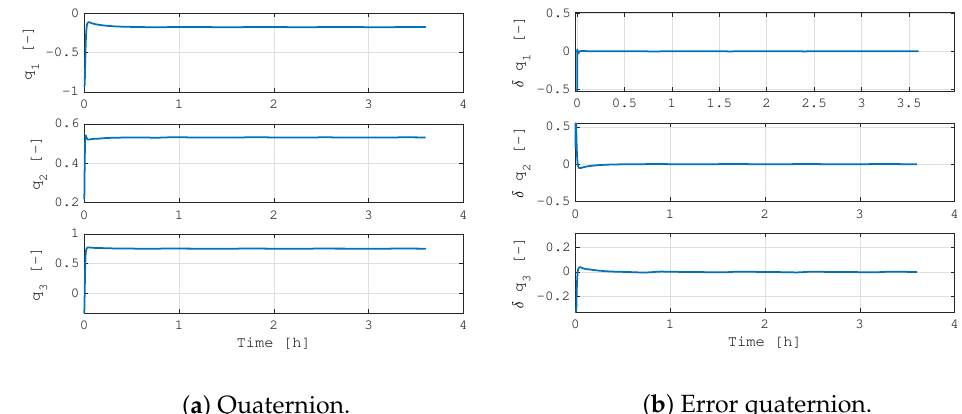
Figure 3. Inertial pointing